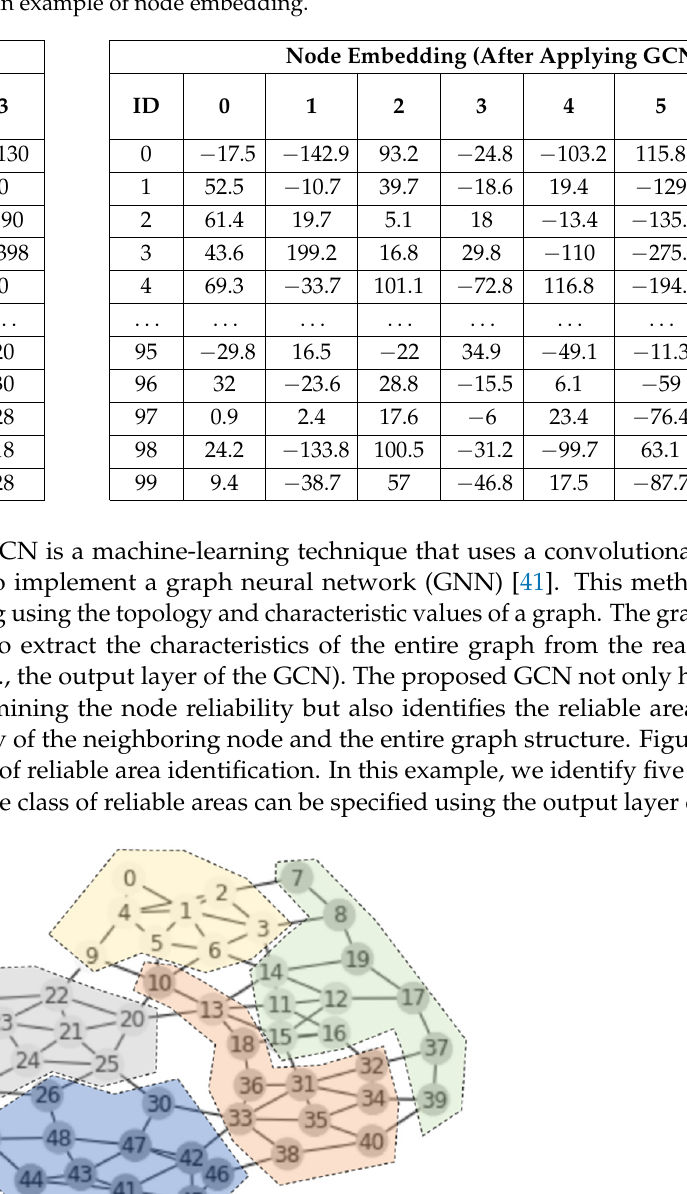
Table 2. An example of node embedding.